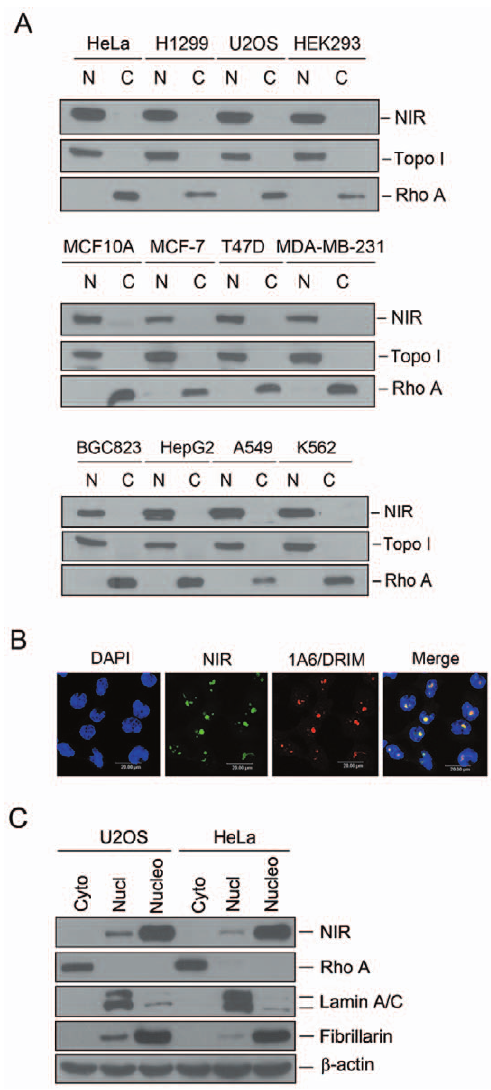
Figure 1. NIR is expressed in different human cell lines and mainly localized to the nucleolus. A. Cytosolic and nuclear extracts were fractionized from multiple cancer cell lines as indicated at the top of blot. Same amount of protein was separated on SDS-PAGE, and transferred onto PVDF membranes. Blots were probed with anti-NIR. Fractionation was controlled by using nuclear marker protein topo- isomerase I (Topo I) and a cytosolic marker protein RhoA. N represents nuclear extract and C represents cytoplasmic extract. B. Indirect immunofluorescence was performed with anti-NIR polyclonal antibody. NIR specific signal was recognized with FITC-conjugated goat anti- rabbit IgG. As a nucleolar protein, 1A6/DRIM was detected with anti- 1A6/DRIM monoclonal antibody. 1A6/DRIM specific signal was recog- nized with TRITC-conjugated goat anti-mouse IgG. Nucleus was stained with DAPI. The image was obtained with confocal microscopy. C. Cytoplasmic, nucleoplasmic and nucleolar lysates were fractionized from U2OS and HeLa cells respectively. Same amount of protein from the above lysates was separated on SDS-PAGE, and transferred onto PVDF membranes. Blots were probed with anti-NIR. Rho A, lamin A/C and fibrillarin were used as controls for cytoplasmic, nucleoplasmic and nucleolar fractions respectively. Beta-actin was used as a loading control.